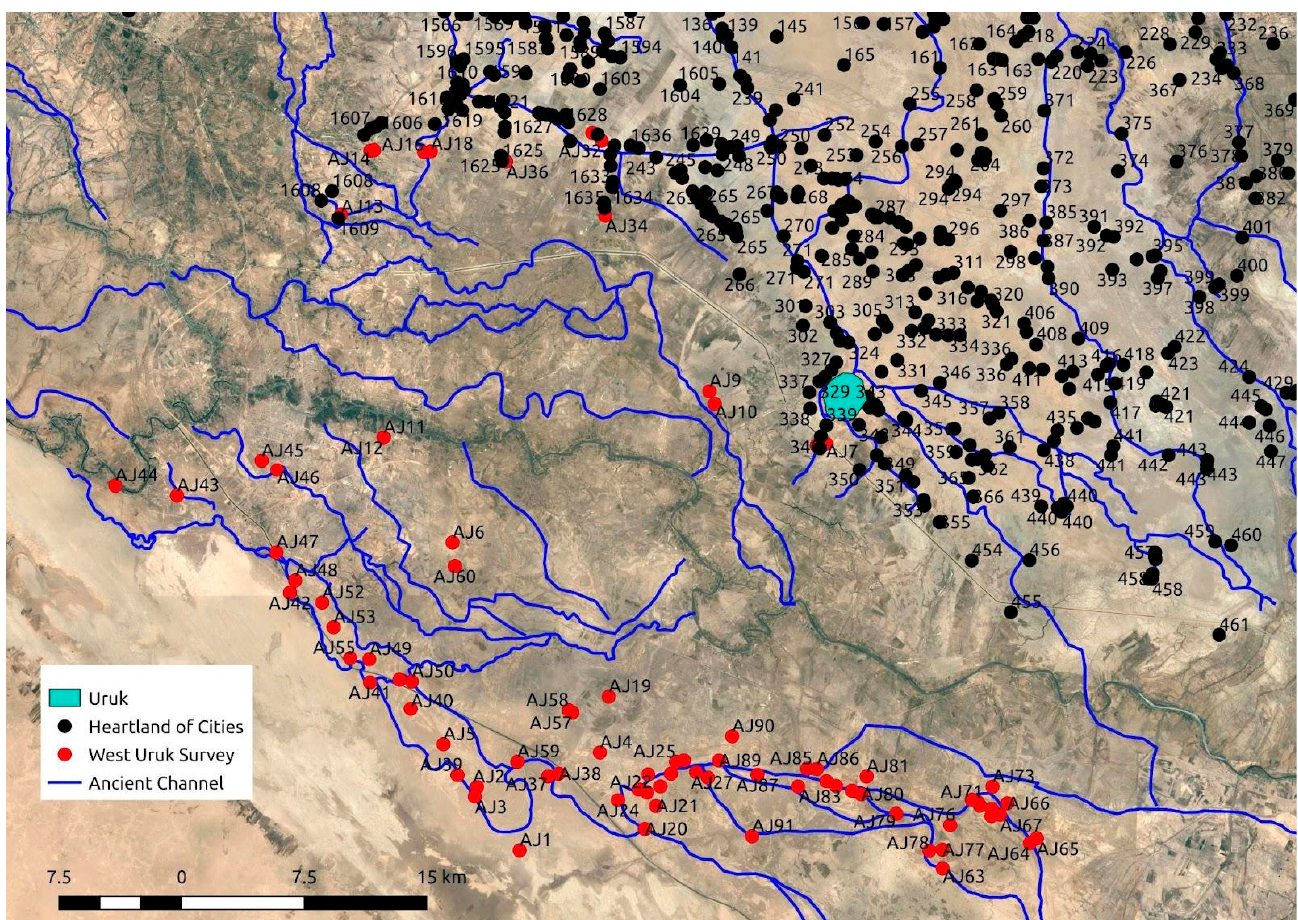
Figure 2. The archaeological surveyed region including the ‘Heartland of Cities’ sites marked in black dots with original numbering derived from [3,4]; the West Uruk Survey was conducted by al-Qadisiyah University [27], sites are marked in red dots with numbering following initials AJ.